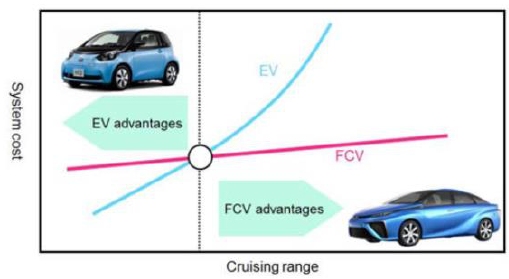
Figure 4. Comparison of battery vehicles (EV) and fuel cell vehicles (FCVs) [13].